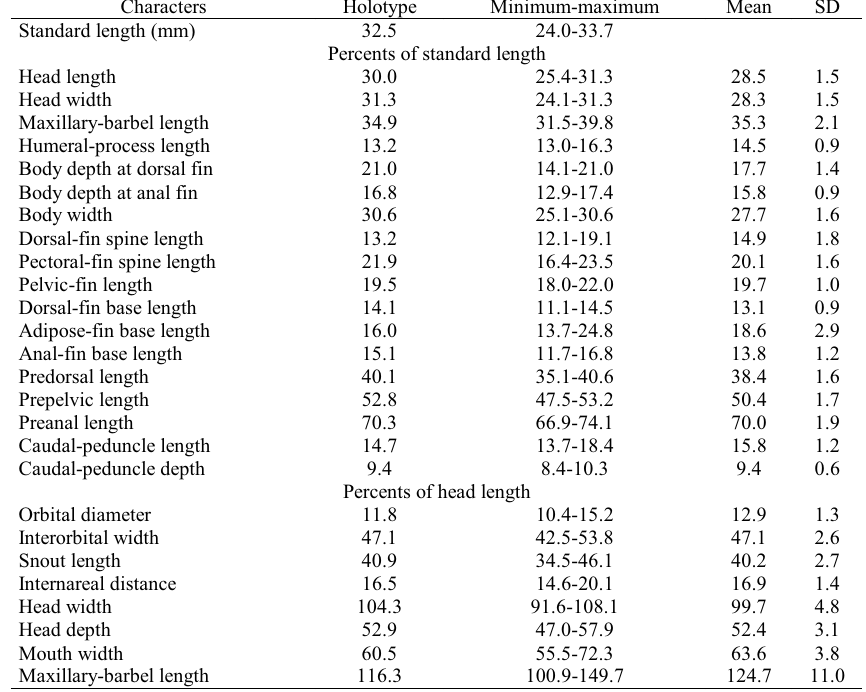
Table 1. Morphometric data for Microglanis carlae , n = 27. Minimum and maximum includes data for holotype and paratypes. SD: standard